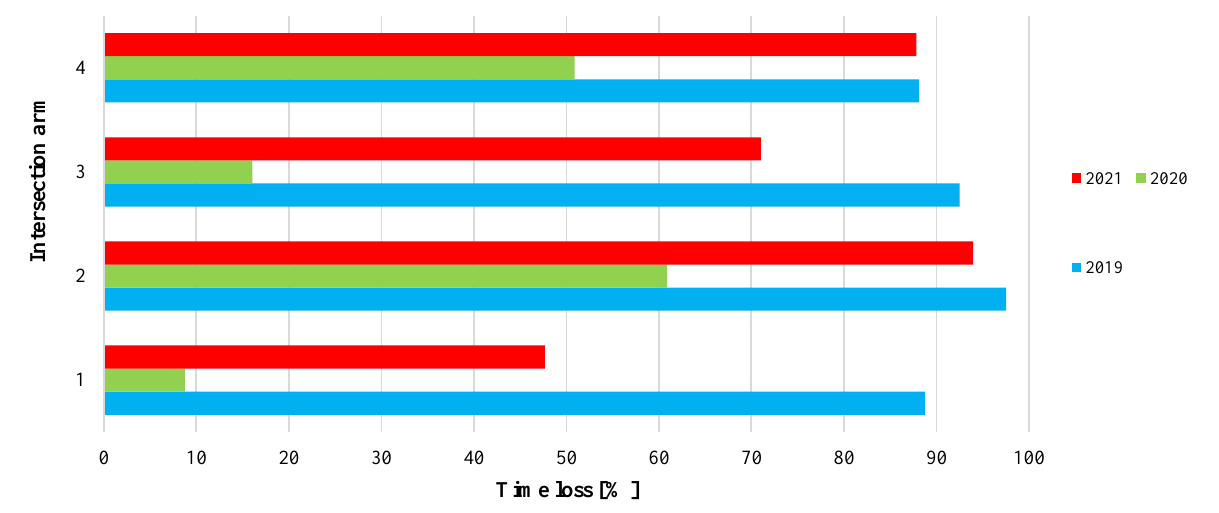
Figure 7. Time loss for individual arms of the intersection.